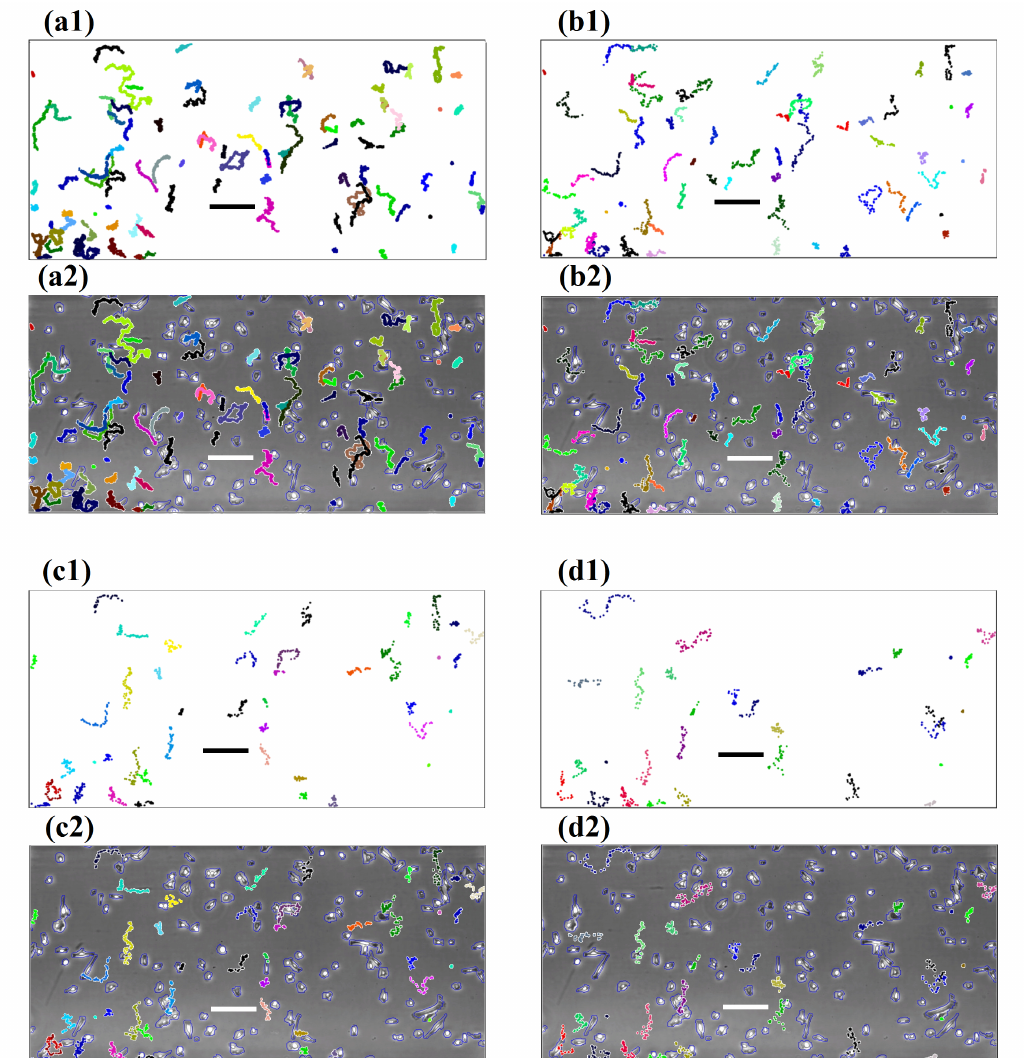
Figure 3. Cell trajectories generated by the fully-automated cell tracking software with different choices of time step intervals. ( a1 – d1 ) These images show trajectories on a plain background. ( a2 – d2 ) Images demonstrate trajectories overlaid on the first image of the sequence. ( a1 , a2 ) Are generated with a 30 s time step interval; ( b1 , b2 ) generated with a 5 min time step interval; ( c1 , c2 ) generated with a 10 min time step interval; and ( d1 , d2 ) generated with a 15 min time step interval. Bars are 200 µ m in